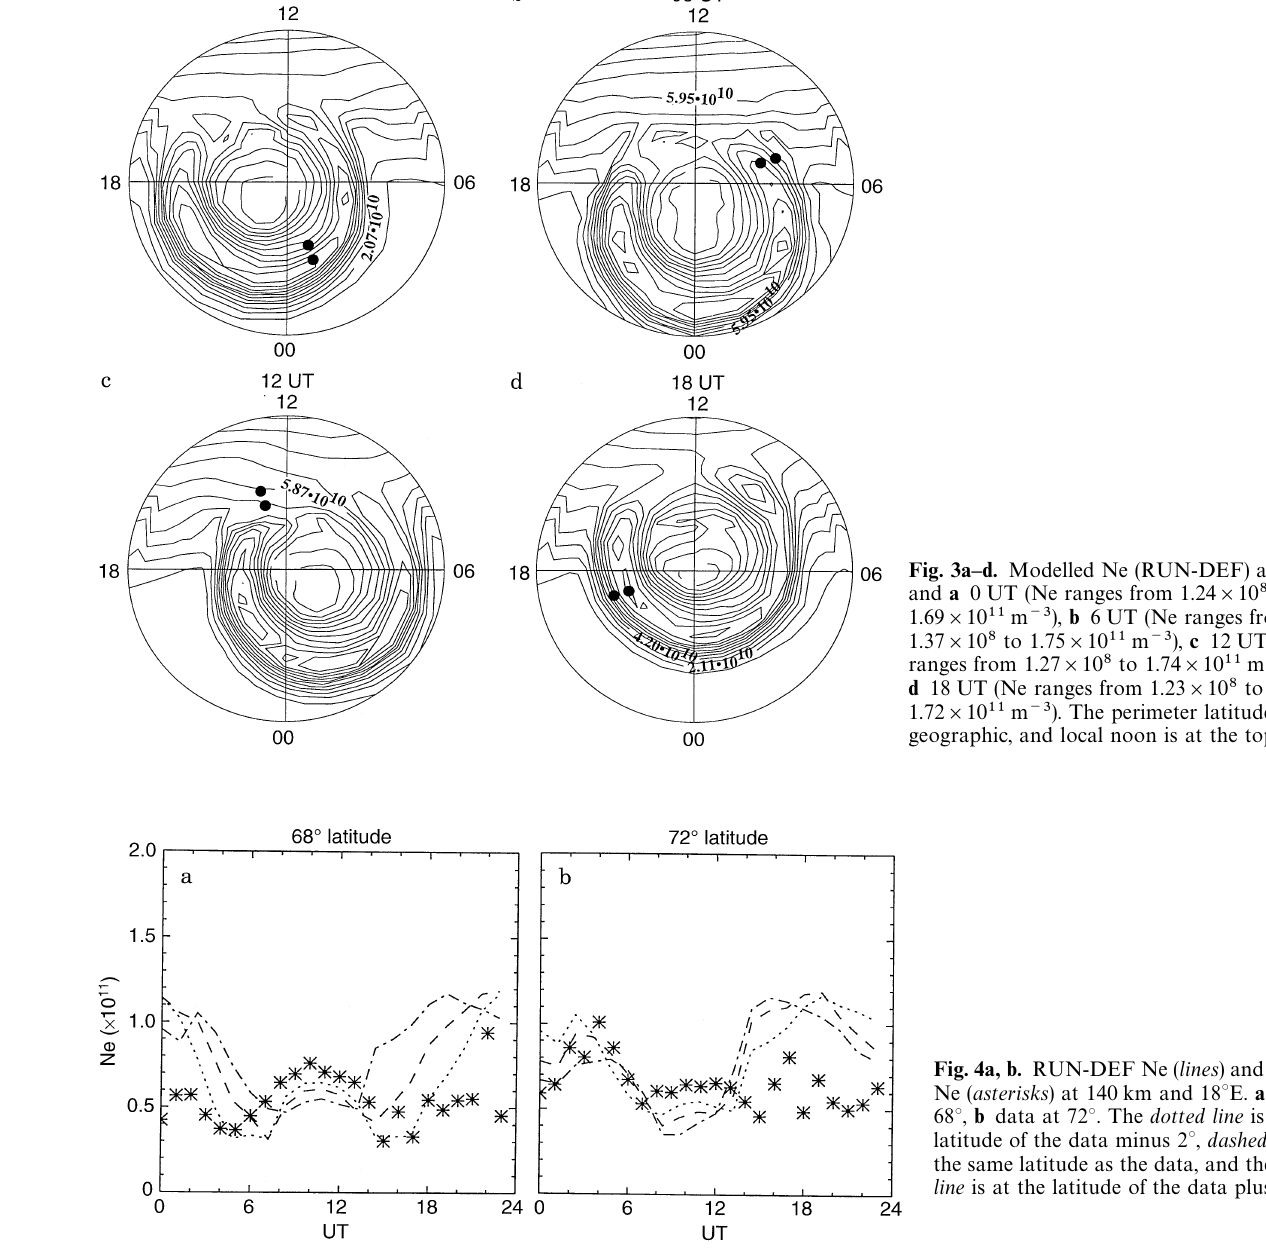
Fig. 3a (cid:177) d. Modelled Ne (RUN-DEF) at 140 km and a 0 UT (Ne ranges from 1.24 (cid:93) 10 (cid:56) to 1.69 (cid:93) 10 (cid:49)(cid:49) m (cid:126)(cid:51) ), b 6 UT (Ne ranges from 1.37 (cid:93) 10 (cid:56) to 1.75 (cid:93) 10 (cid:49)(cid:49) m (cid:126)(cid:51) ), c 12 UT (Ne